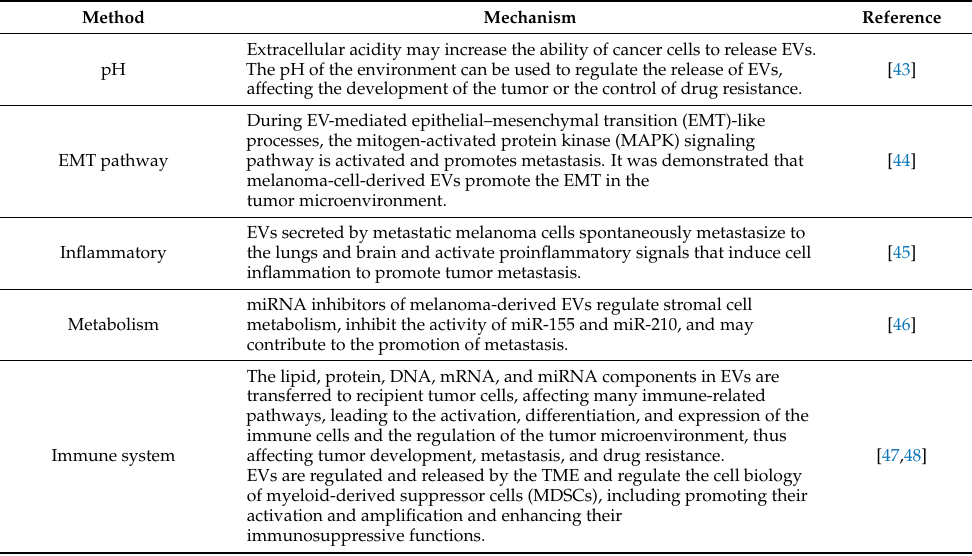
Table 1. The mechanisms of tumor microenvironment regulations in